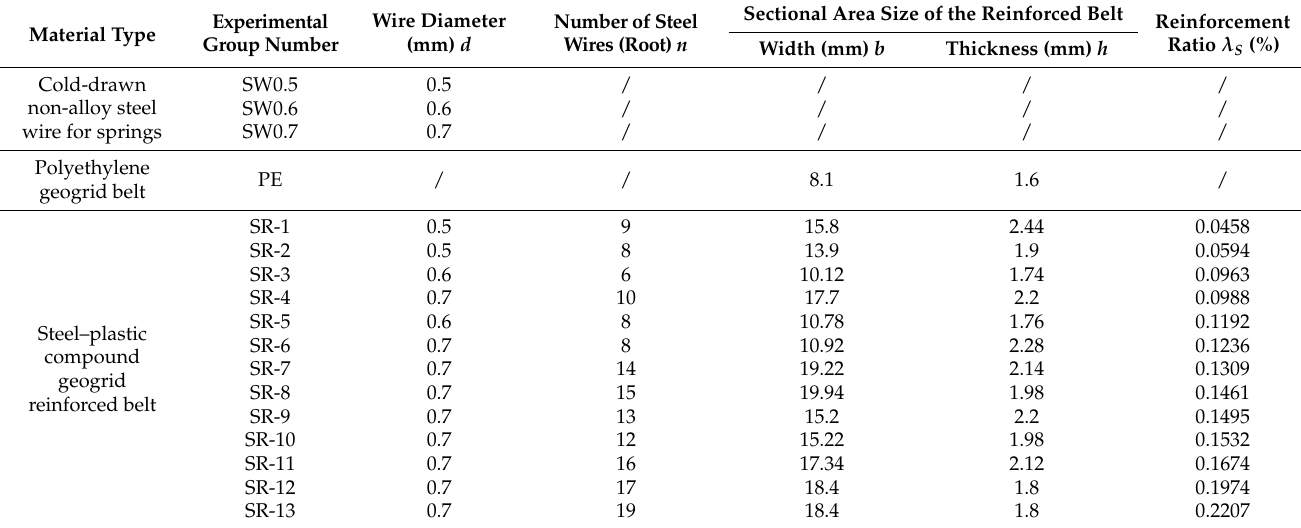
Table 1. Design specifications of experimental